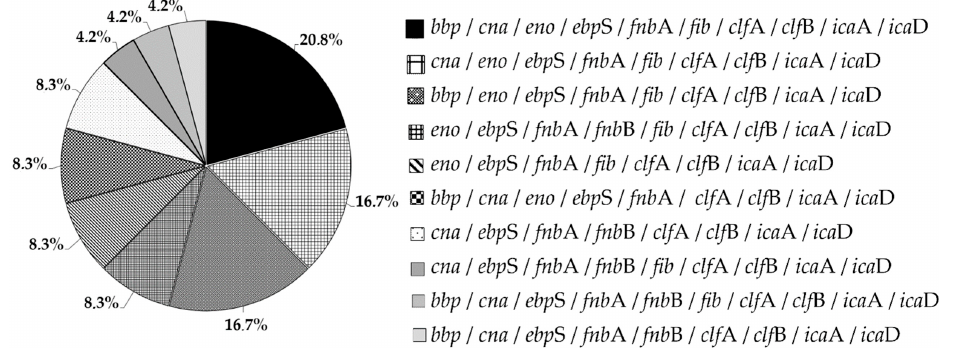
Figure 6. The frequency of combination of ica operon genes and genes encoding proteins from the MSCRAMM family in the studied S. aureus strains.